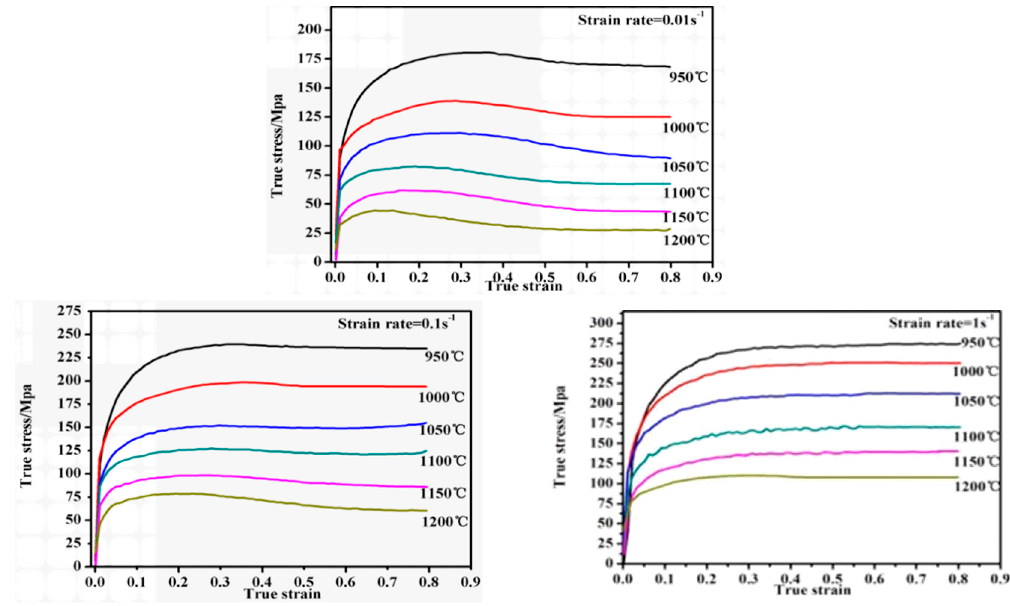
Figure 1. True strain-true stress curves of Nb-contained 316LN.